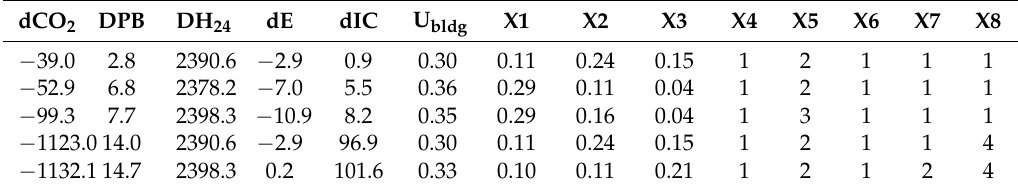
Table A4. Optimal Pareto solutions for Case 2 ( P 2).